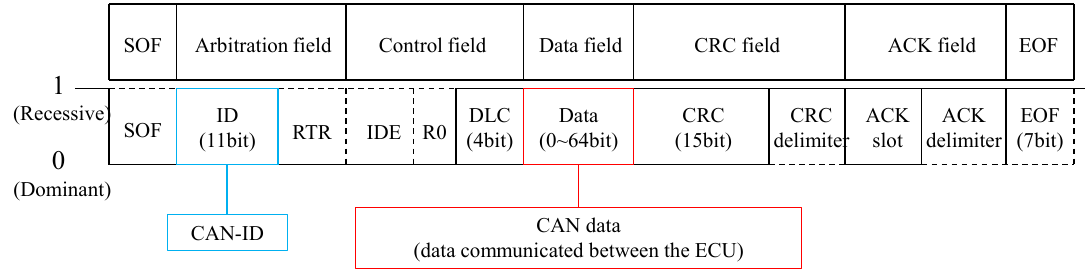
Fig. 3. The structure of data